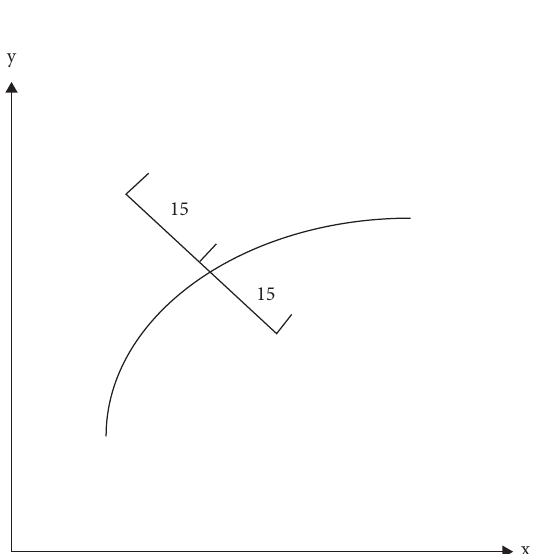
Figure 5: Search 15 points up and down in the direction of the normal.